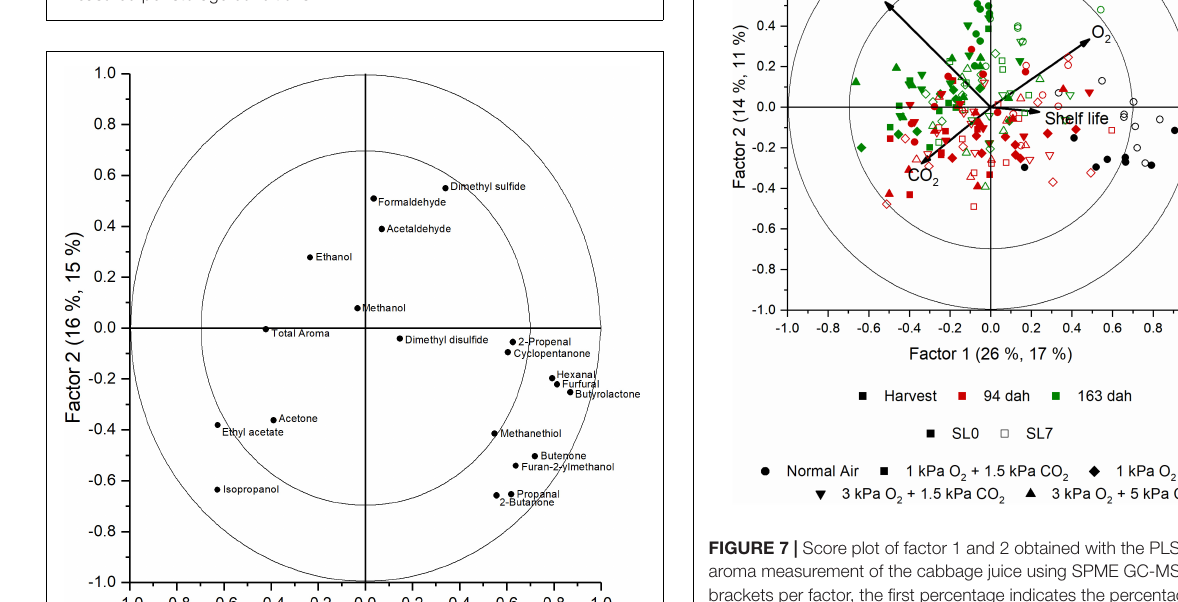
FIGURE 5 | Score plot obtained with the PLS analysis of the aroma measurement of the container headspace of storage containers using TD-GC-MS. Between the brackets per factor, the first percentage indicates the percentage of which part of the aroma variables are represented in the projection of this dimension, while the second percentage indicates to what extent the response is explained by this. The different objects are color- and shape-coded based on time and treatment, respectively, as indicated in the legend. Start includes measurements of seven (i.e., biological replicate) containers when the different storage regimes are started. For 86 and 155 days after storage started, two and three biological replicates were measured per storage conditions.